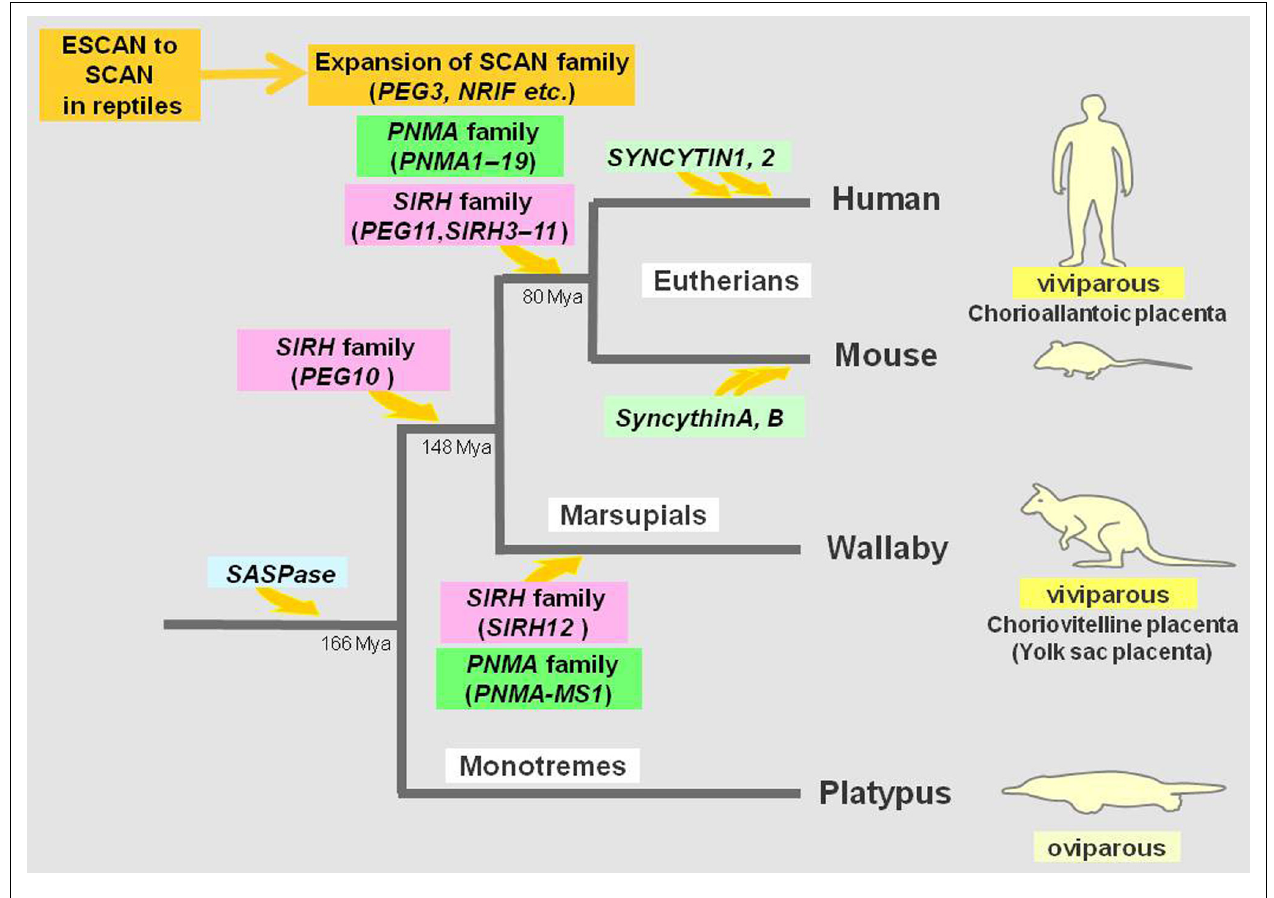
certain reptiles. In any event, the expansion of SCAN family is obvious in the eutherians. SIRH12 and PNMA-MS1 are derived from marsupial- specific domestication events.The SYNCYTINs were independently recruited in several different mammalian lineages.The eutherians and marsupials are viviparous, having chorioallantoic and choriovitelline placentas (yolk sac placentas), respectively. Both PEG10 and PEG11/RTL1 are essential for the proper formation of efficient chorioallantoic